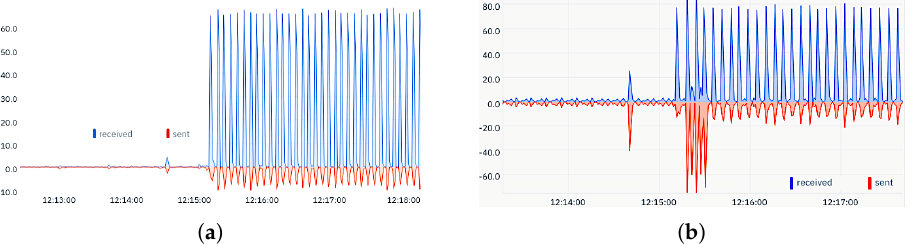
Figure 9. Network bandwidth consumption by the devices; (y → bandwidth in kb/s and x → time),